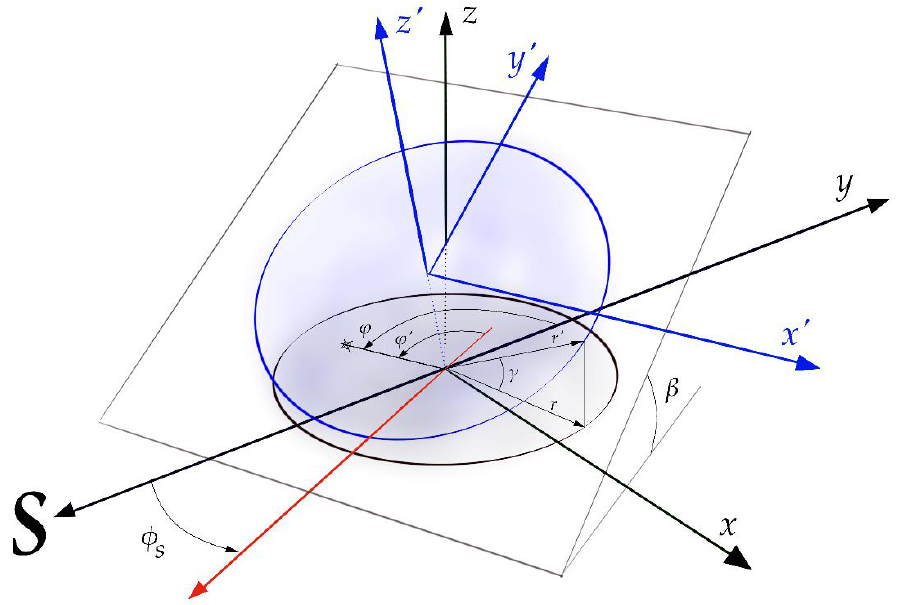
Figure 9. Sketch of an arbitrary tilted and oriented plane and the transposition of the coordinated reference system.